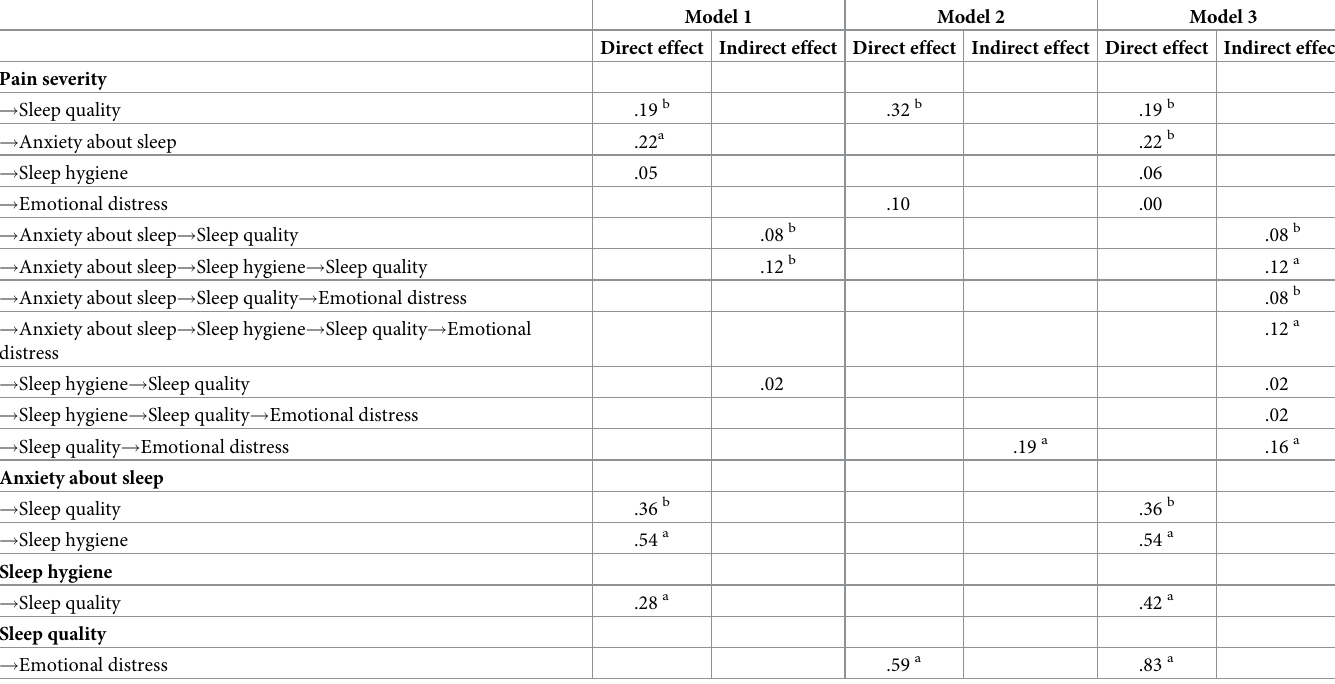
Table 3. Standardized direct and indirect effects for models